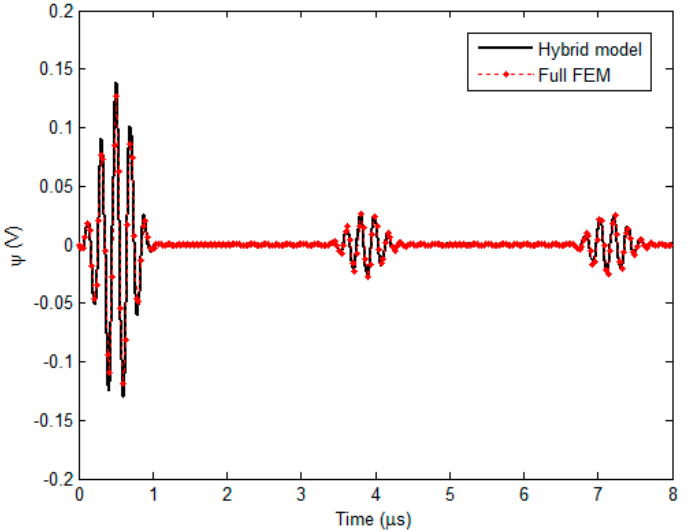
Figure 7. Comparison of the predicted EMAT signal between the hybrid model and full FEM.